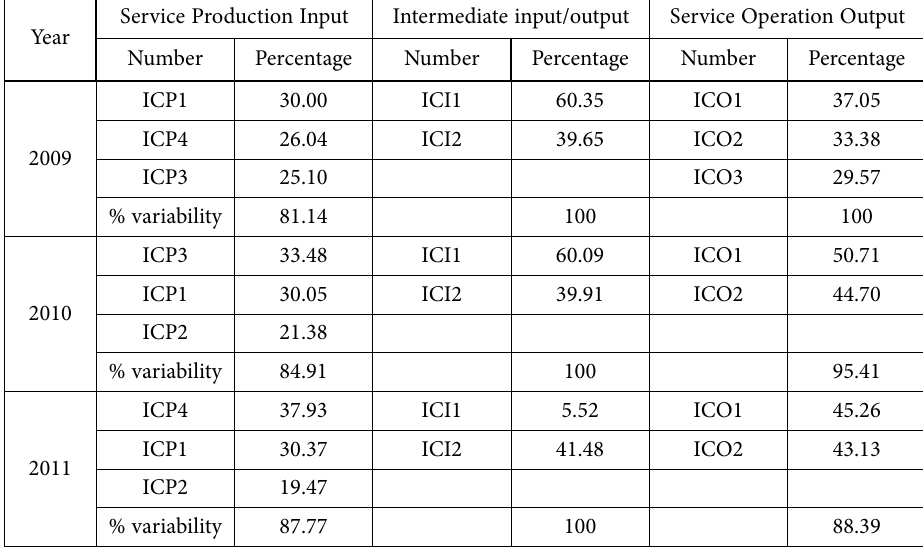
Table 4. Sorted ICs in terms of explained